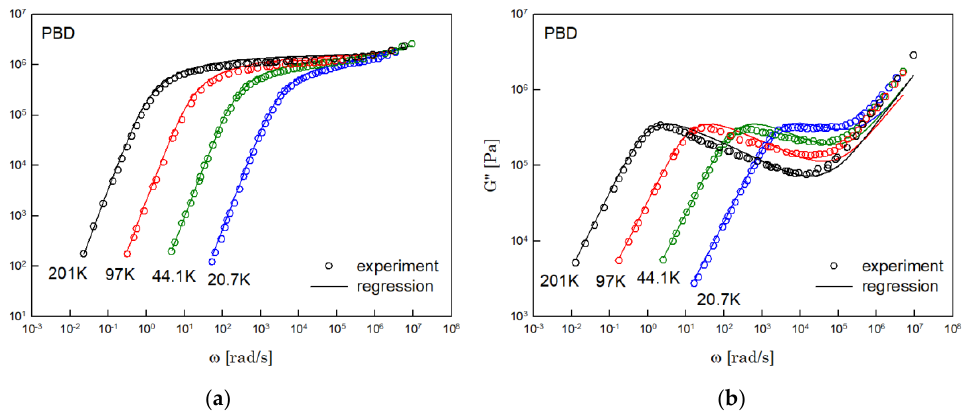
Figure 4. Comparison the regression results (lines) with the experimental data (symbols) of ( a ) storage modulus and ( b ) loss modulus of PBD. These experimental data are measured by Baumgaertel and Winter [16].